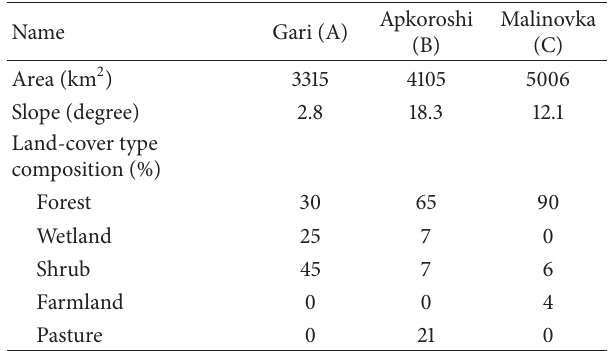
Table 1: Basic geographic information of test